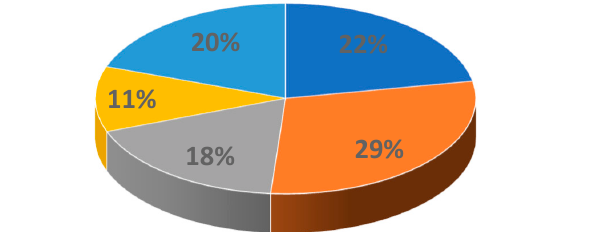
Figure 1. Percentage of identified processes in the surveyed community offices (n = 174). Source: Own work based on research results.